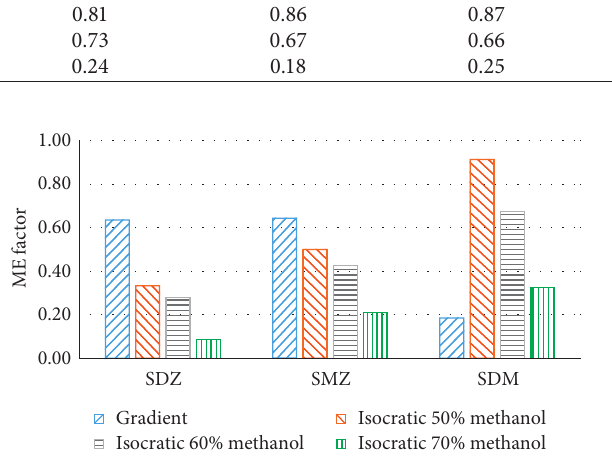
Figure 3: The matrix effect factors of the target analytes with four kinds of mobile phase elution conditions ( n � ( u ), balance weighing ( u ; including weighing of rel , p rel , w standards and standard solutions, isotope labeled standards and standard solutions, and milk samples), and the method � √ n precision ( u ; s / ). rel , rep